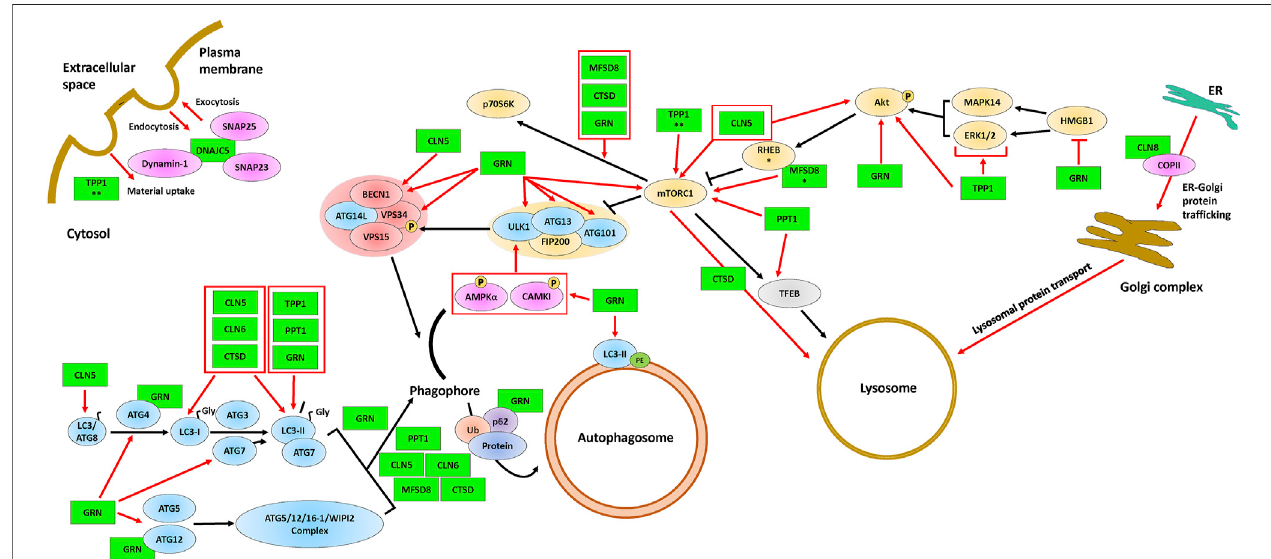
FIGURE 2 | The involvement of CLN proteins in endocytosis, exocytosis, ER-Golgi protein traf fi cking, autophagosome formation, and lysosome formation. The ULK1complex(proteinsabovetheyellowbackground),theClassIIIPI3KcomplexI(proteinsabovetheredbackground),andtheautophagyproteins (blue)arerequired for the formation and maturation of autophagosomes. Some of the CLN proteins (green) affect mTORC1, a protein complex that regulates autophagosome formation andlysosomalbiogenesis via TFEB.TheblackarrowsindicatetheautophagypathwayandredarrowsindicatesupportingevidenceofaneffectofaCLNproteinon a given autophagic process. Protein overlaps are representative of protein-protein interactions. * indicates the observation was made only for the D. melanogaster homolog and ** indicates the observation was made only for the D. discoideum homolog. Note that the positions of the CLN proteins depicted in the fi gure are not necessarilyrepresentativeoftheiractuallocalizationinthecell.Pleasereferto Table1 forinformationonthelocalizationsofthedifferentCLNproteins.Akt,proteinkinase B; AMPK α , AMP-activated protein kinase α 1/2; ATG3, ubiquitin-like-conjugating enzyme ATG3; ATG4, cysteine protease ATG4; ATG5, autophagy protein 5; ATG7, ubiquitin-like modi fi er-activating enzyme ATG7; ATG9, autophagy protein 9; ATG12, ubiquitin-like protein ATG12; ATG13, autophagy-related protein 13; ATG14L, BECN1-associated autophagy-related key regulator-like; ATG16-1, autophagy-related protein 16-1; ATG101, autophagy-related protein 101; BECN1, beclin-1; CAMKI, calmodulin-dependent protein kinase I; CLN5, ceroid lipofuscinosis neuronal 5; CLN6, ceroid lipofuscinosis neuronal 6; CLN8, ceroid lipofuscinosis neuronal 8; COPII, coat protein complex II; CTSD, cathepsin D; DNAJC5, DnaJ heat shock protein family Hsp40 member C5; Dynamin-1, dynamin-1; ER, endoplasmic reticulum; ERK1/2, extracellular signal-regulated protein kinase 1/2; FIP200, focal adhesion kinase family interacting protein of 200 kDa; GRN, progranulin; HMGB1, high mobility group box 1; LC3/ATG8; microtubule-associated protein 1A/1B-light chain 3/autophagy-related gene 8; LC3-I, processed LC3; LC3-II, lipid-attached membrane- bound LC3; MAPK14, mitogen-activated protein kinase 14; MFSD8, major facilitator superfamily domain containing 8; mTORC1, mammalian target of rapamycin complex 1; P, phosphate; p62, p62/sequestosome 1; p70S6K, p70 S6 kinase; PE, phosphatidylethanolamine; Protein, protein cargo; PPT1, palmitoyl protein thioesterase 1; RHEB, ras homolog enriched in the brain; SNAP23, synaptosomal-associated protein 23; SNAP25, synaptosomal-associated protein 25; TFEB, transcription factor EB; TPP1, tripeptidyl peptidase 1; Ub, ubiquitin; VPS15, vacuolar protein sorting 15; VPS34, vacuolar protein sorting 34. ULK1, UNC51-like autophagy activating kinase 1; WIPI2, WD repeat domain phosphoinositide-interacting protein